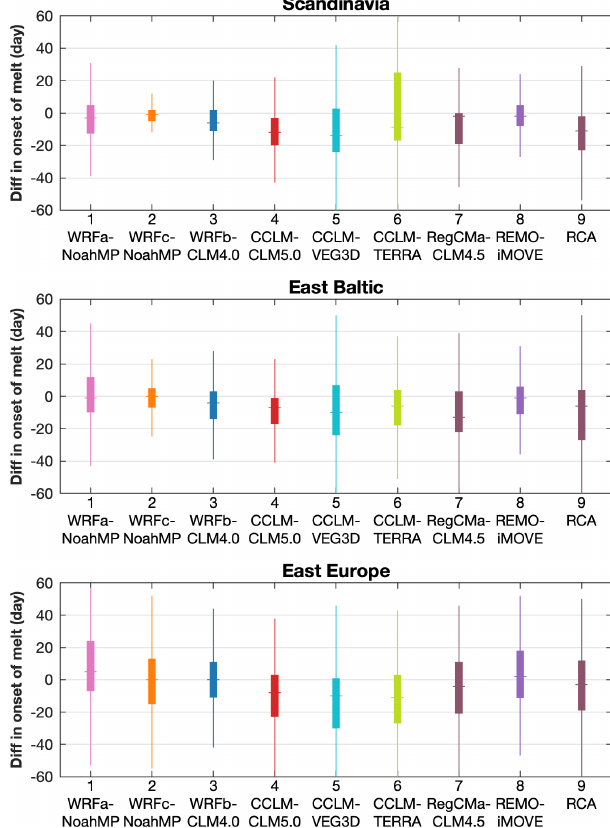
Figure 6. Impact of afforestation (FOREST − GRASS) on the num- ber of snow days in the season, an indicator for the length of the snow season.